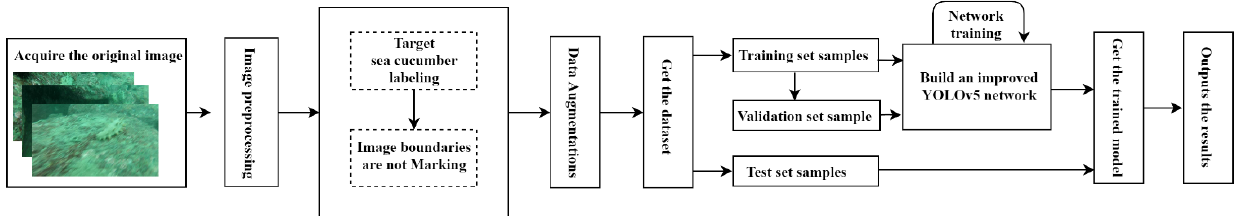
Figure 1. Sea cucumber identification flowchart.